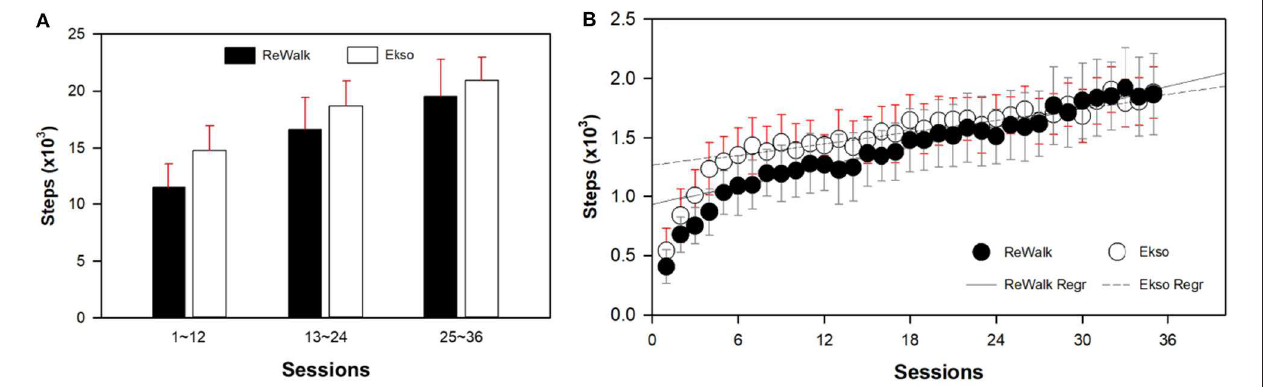
FIGURE 2 | Results of average steps per session block (A) and by session (B) split by device. Both those using the ReWalk ( r 2 = 0.0956, y = 27.90x + 931.24) and Ekso ( r 2 = 0.082, y = 16.62x + 1267.96) took more steps during later sessions. Since the first 6 sessions were pilot sessions where the participants were introduced to the device, the linear regression models were performed with data from sessions 7 to 36. The Ekso users increased the number of steps per session by 6 to 12 sessions then plateaued, whereas, the ReWalk users initially had less steps per session, but progressively increased by 36